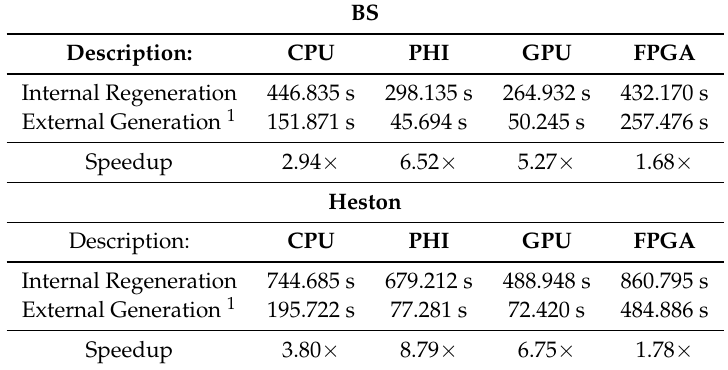
Table 4. Kernels’ speedup between external and internal RN sequences (Table 3 vs. Table